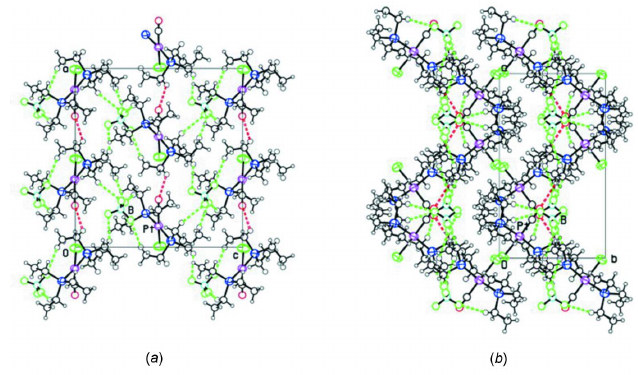
Figure 2 Projections of the structure down the b axis ( a ) and c axis ( b ), with arbitrary sphere sizes for the atoms. The reference cation and anion have Pt and B atoms identified. Putative C—H (cid:3)(cid:3)(cid:3) O and C—H (cid:3)(cid:3)(cid:3) F hydrogen bonds are shown as red and green dashed lines, respectively.